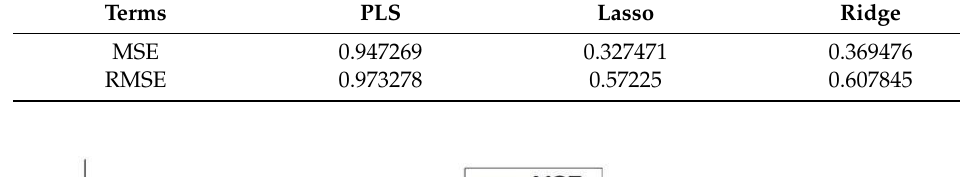
Table 8. MSE and RMSE values of three models.